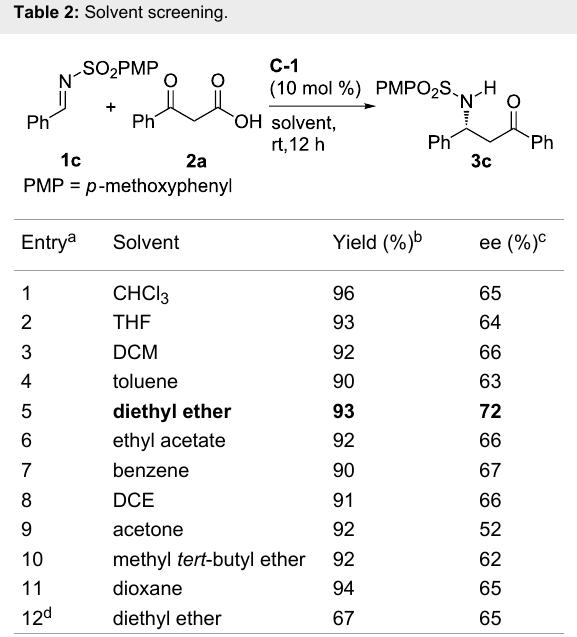
Table 3: Substrate scope.